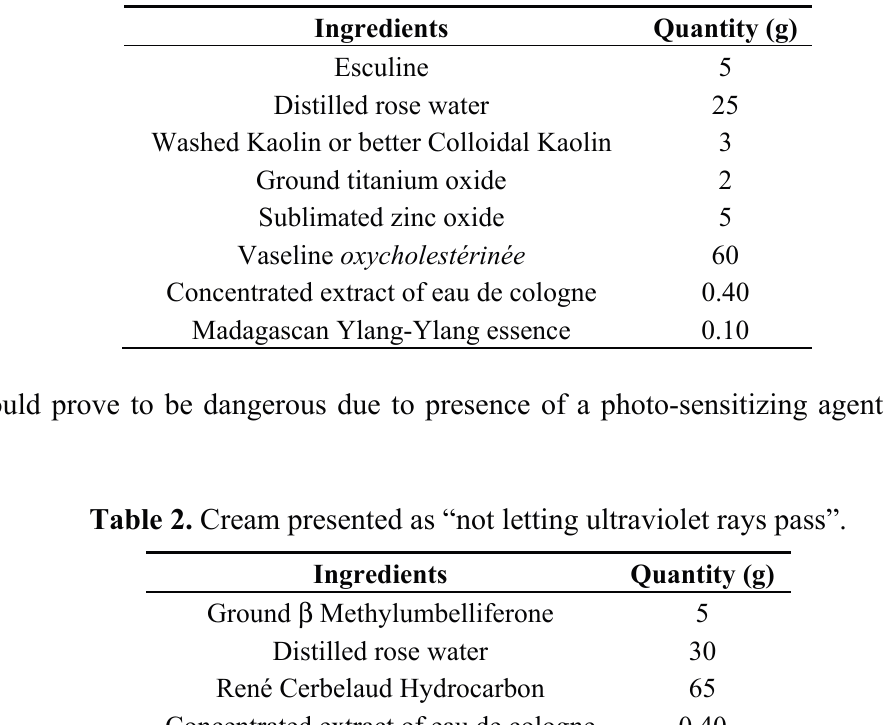
Table 1. Cream presented as being “for use when spending time on snow or glaciers—recommendable formula”.